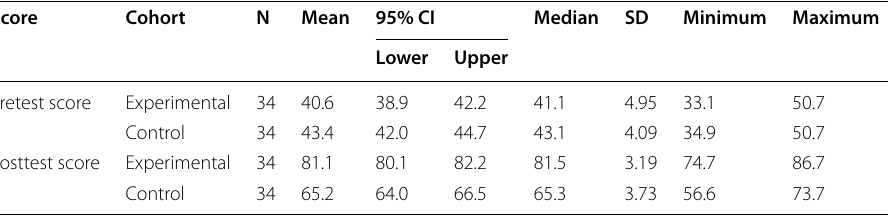
CI confidence interval